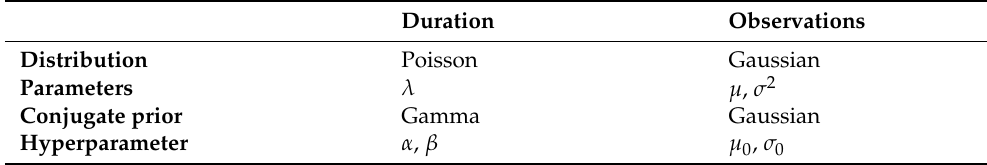
Table 1. Distributions and parameters for state duration and magnitude and their conjugate